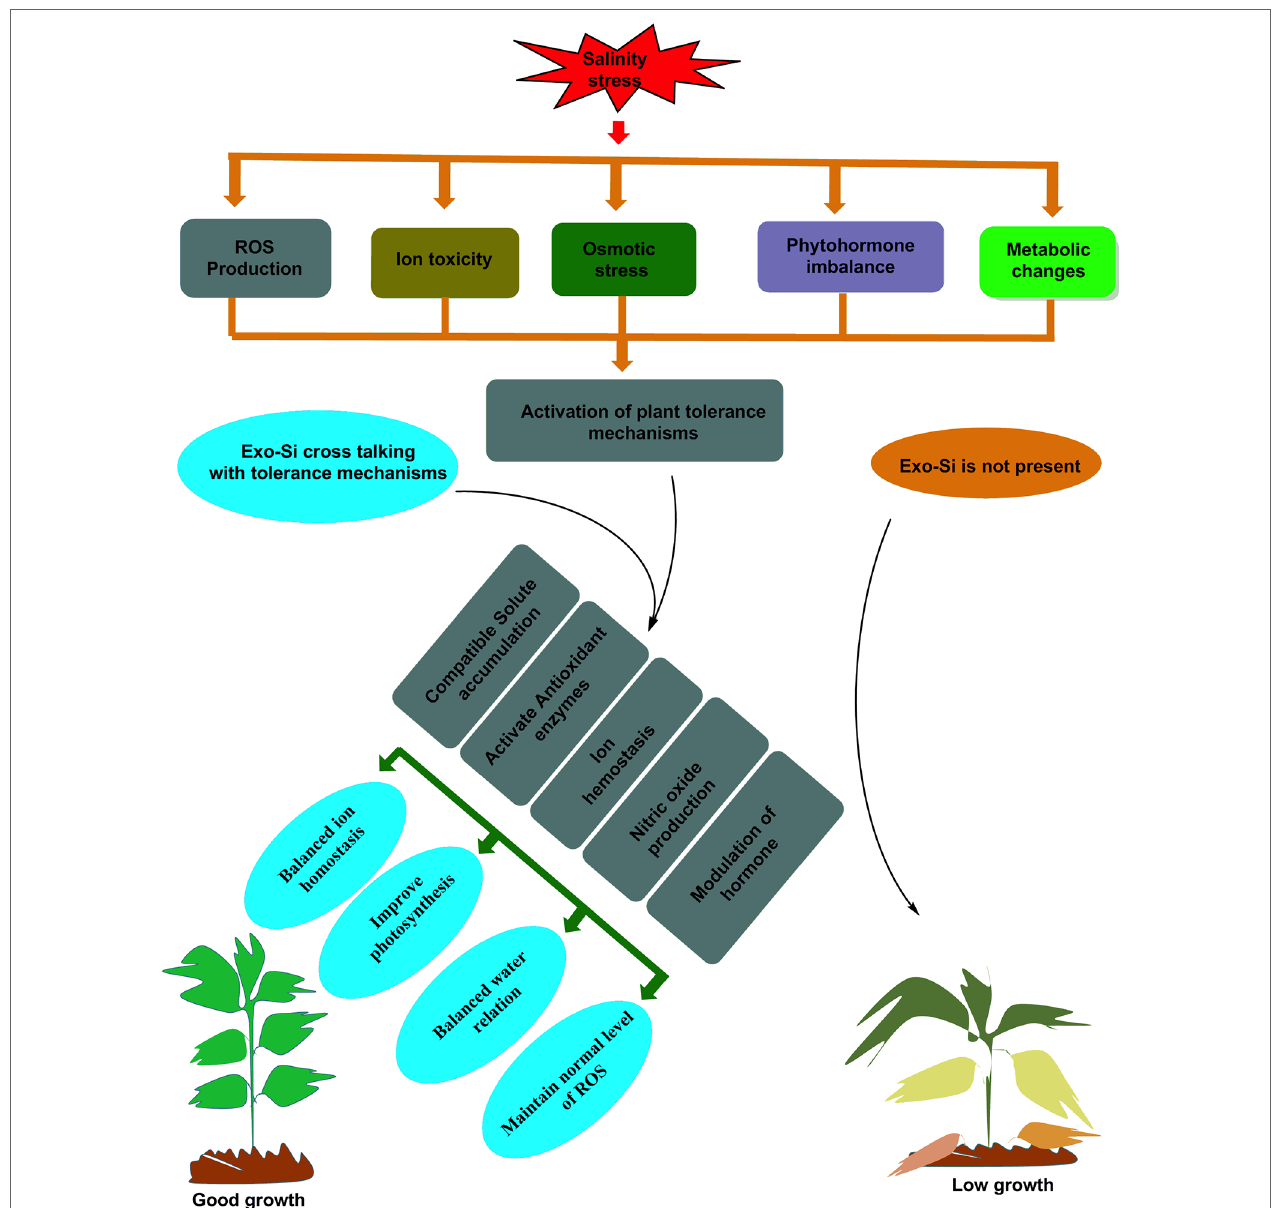
FIGURe 4 | Schematic representation of silicon crosstalk with plants tolerance mechanisms during salinity